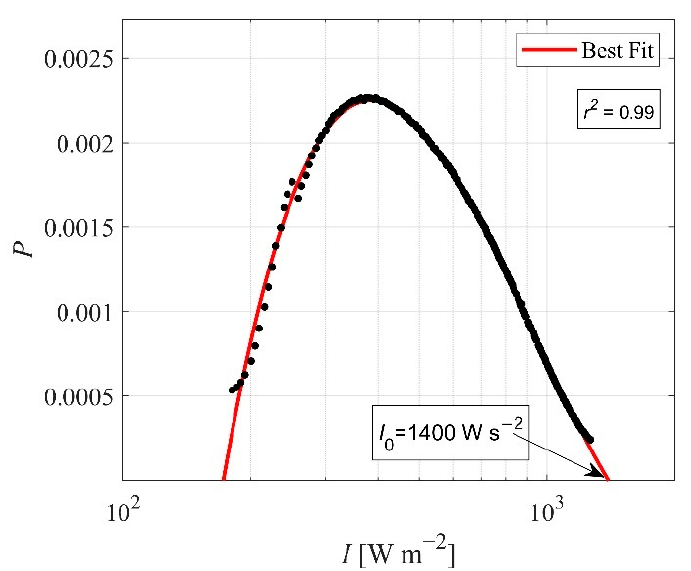
Figure 5. The probability density distribution of the attenuated laser intensity with initial laser intensity, I 0 = 1400 W s − 2 , from January to October in 2015.